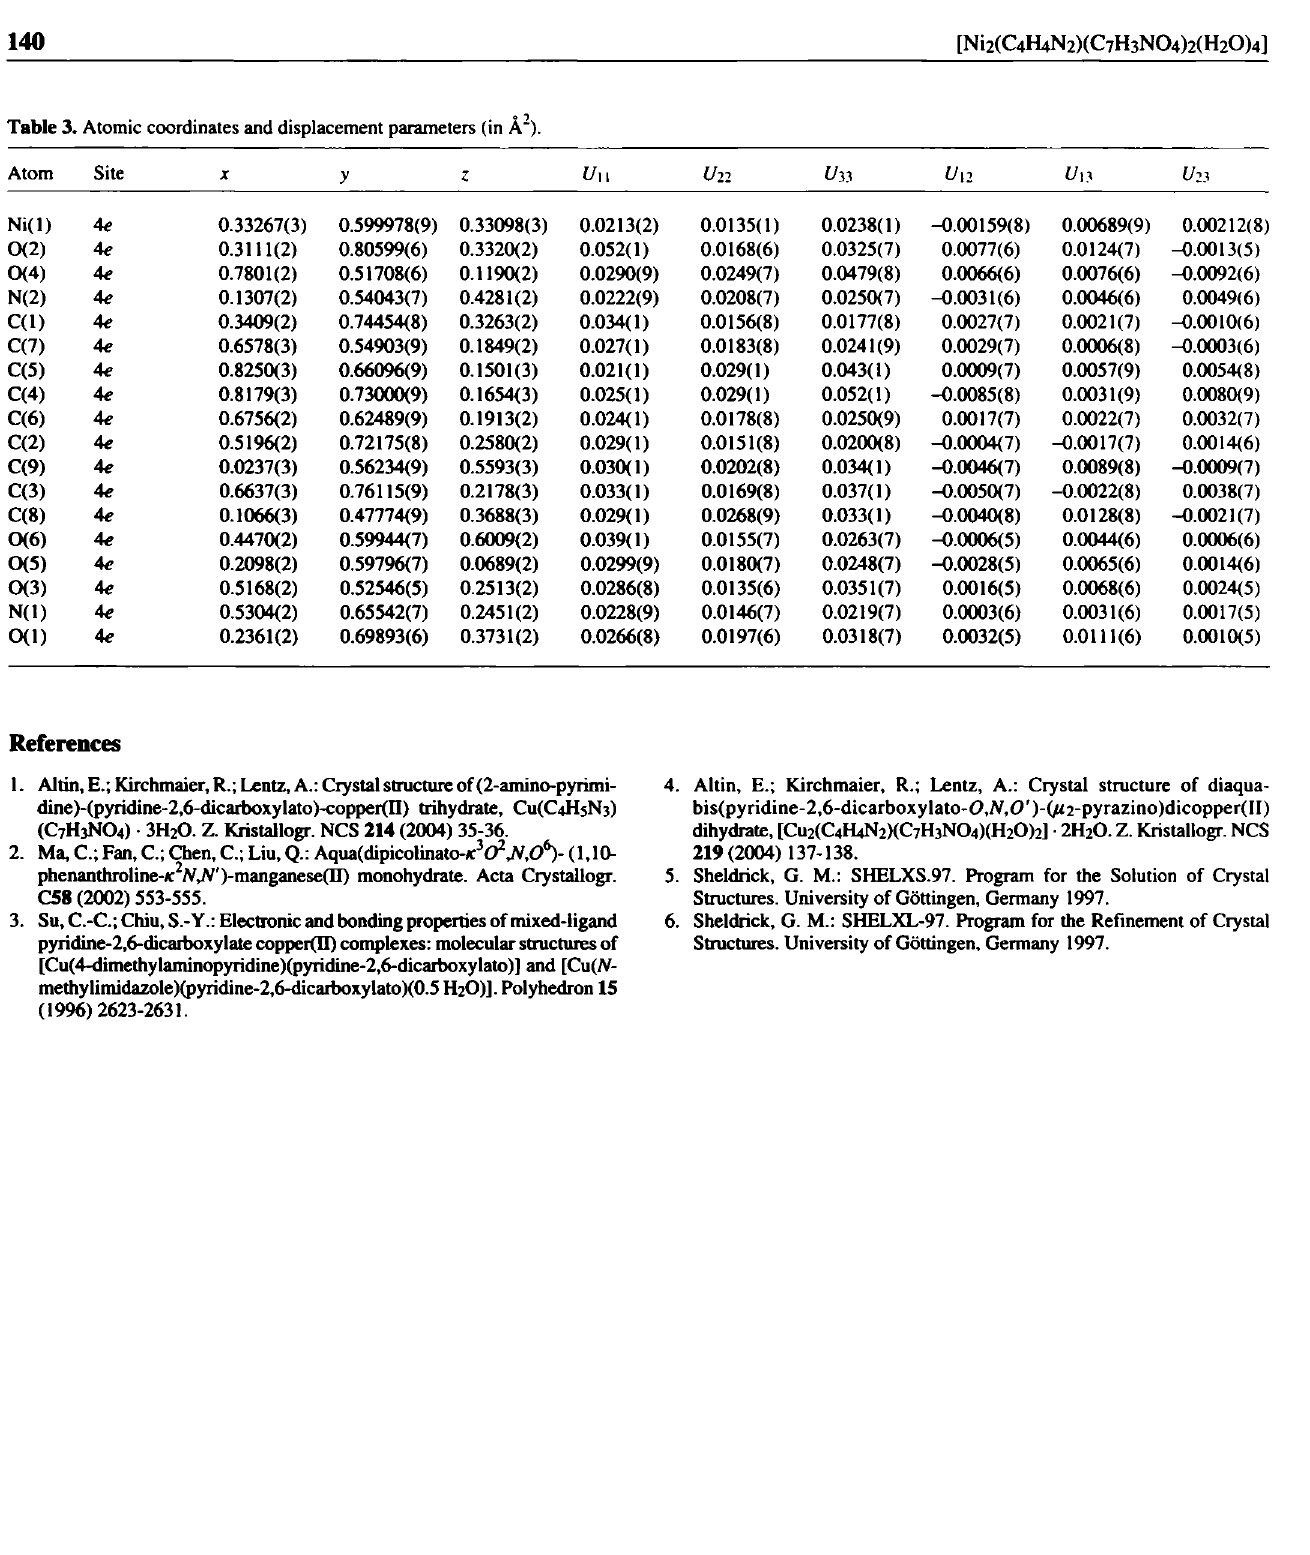
Table 3. Atomic coordinates and displacement parameters (in Â 2